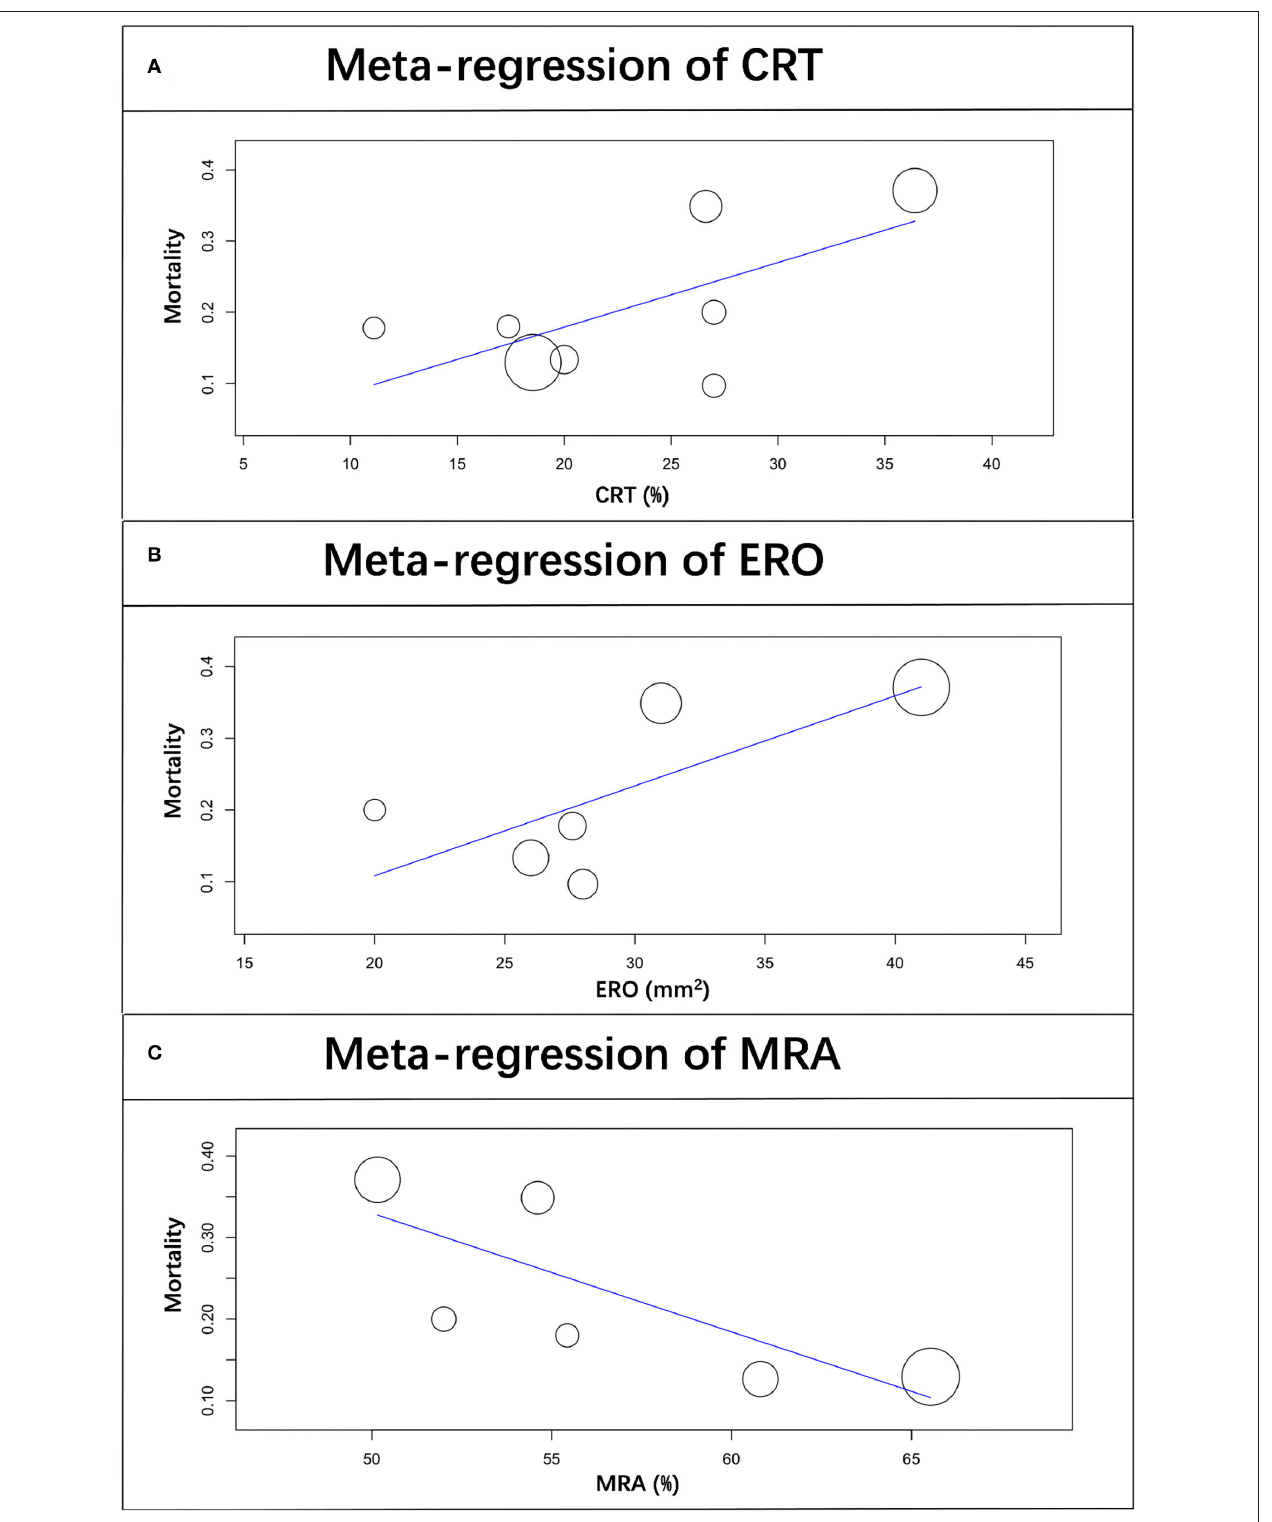
FIGURE 4 | Scatterplot showing the relationship between mortality and CRT therapy (A) , ERO (B) , and MRA prescription (C) in patients with SMR undergoing PMVR. The size of each point correlates with the number of patients in each included study.